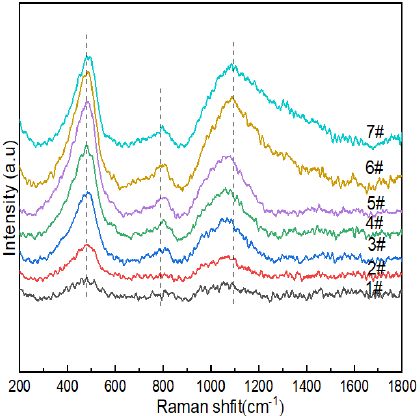
− Al − SiO 2 O 2 O 3 2 system glass with different B 2 O 3 contents.